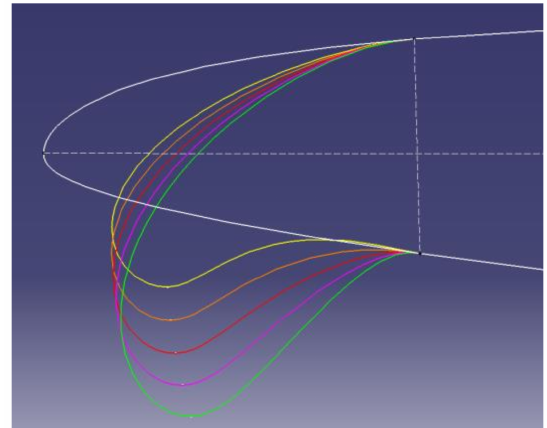
Figure 2. Different leading edge profiles in the deflection angles of 20, 25, 30, 35, and 40 ◦ with a leading edge radius of 14